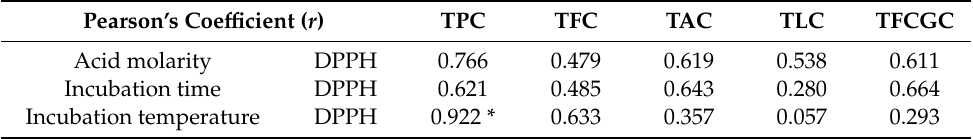
Table 3. Pearson’s coe ffi cient of flavonoid C -glycosides and DPPH free radical scavenging activity at di ff erent acid hydrolysis